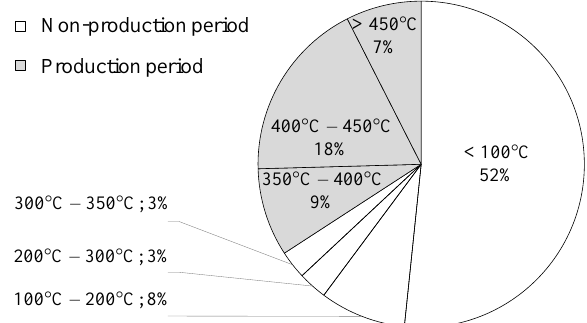
Figure 3. Waste heat temperatures based on 15-week data.